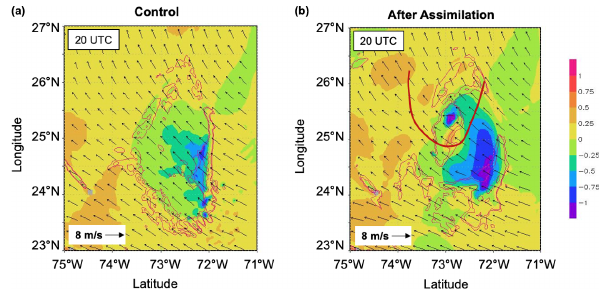
Figure 18. Cold pool structure and development, showing the im- pact of assimilating DAWN winds at 19:00UTC. The cold pools are depicted by the 2m temperature anomaly (from the initial state) at 20:00UTC, after 1h of model integration following the 19:00UTC assimilation. Overlaid are the cold pools (in Kelvin, shaded), precip- itation during the 19:00–20:00UTC model integration (contoured in thin red lines), and wind at the 500m level (vectors). (a) Con- trol run. (b) After assimilation of the DAWN wind profile data. The thick red line indicates the approximate boundary of the observed cold pool created by downdrafts, as analyzed from dropsonde data by Zipser and Rajagopal